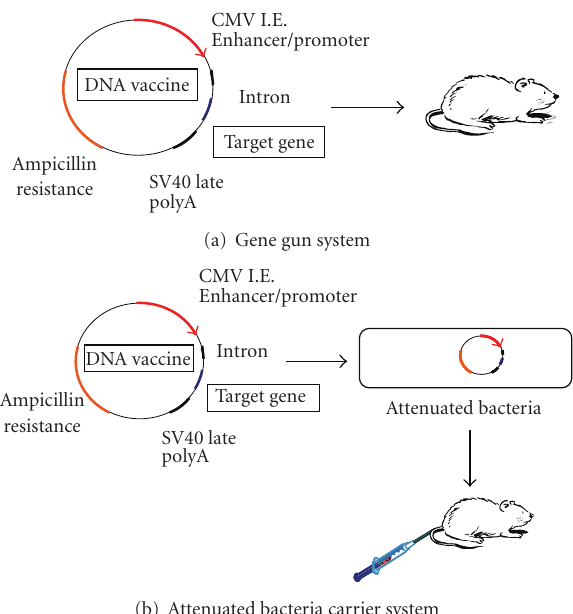
Figure 1: DNA vaccination system. (a) Naked DNA vac- cination. Eukaryotic expression plasmids that have a strong enhancer/promoter such as cytomegalovirus immediate-early pro- moter/enhancer are used as DNA vaccines. Naked DNA vaccination carried out by needle injection (intramuscular, subcutaneous), gene gun bombardment, or topical application to skin. (b) Live attenu- ated bacteria carrier DNA vaccination. Live attenuated intracellular bacteria, such as Listeria , Shigella , or Salmonella , are used as carriers of DNA vaccines. They were given orally or parenterally (needle